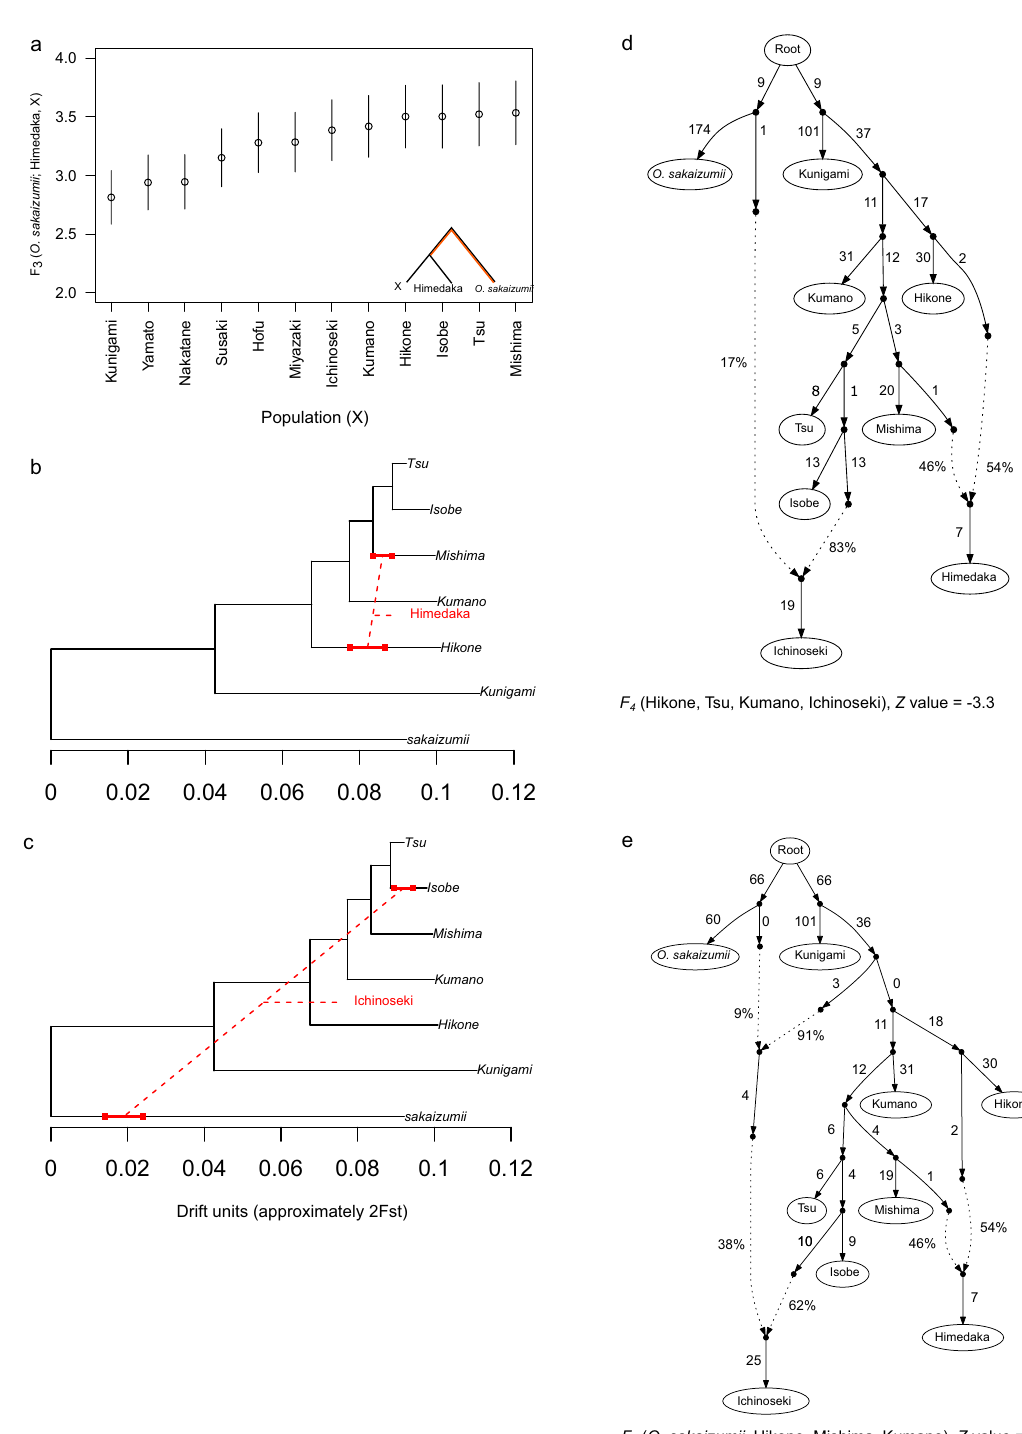
Figure 5. Admixture analyses focusing on the Himedaka and Ichinoseki populations. ( a ): Outgroup F 3 statistics confirm which population is most closely related to Himedaka using O. sakaizumii as the outgroup. ( b , c ): Drift tree of unadmixed and admixed populations, where we assumed that the Himedaka strain ( b ) and Ichinoseki population ( c ) as hybrid populations. Tree branches, branches for drift following admixture, and range of the pre-split position were estimated by MixMapper (see Tables S6, S8). ( d , e ): Admixture graphs that fit the data. The branch length of the F 2 drift distance is represented by the solid line and admixture events are represented by dotted lines with mixture proportions as